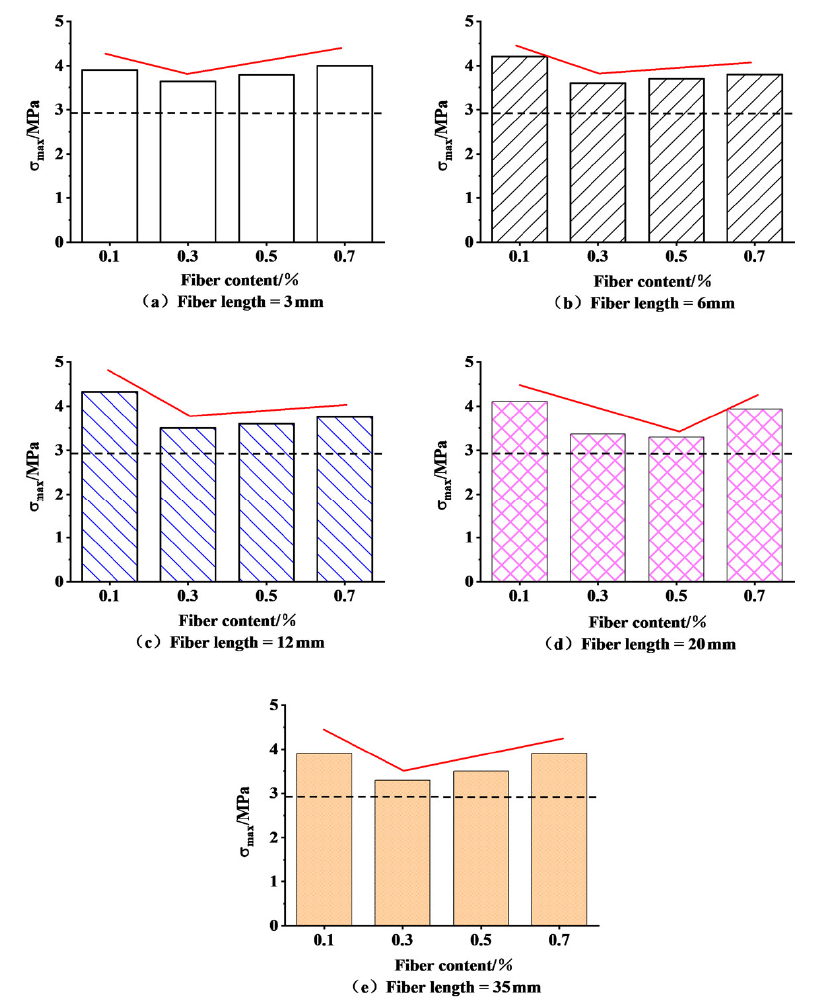
Figure 9. Variations in the peak strength with fiber content and different fiber lengths.